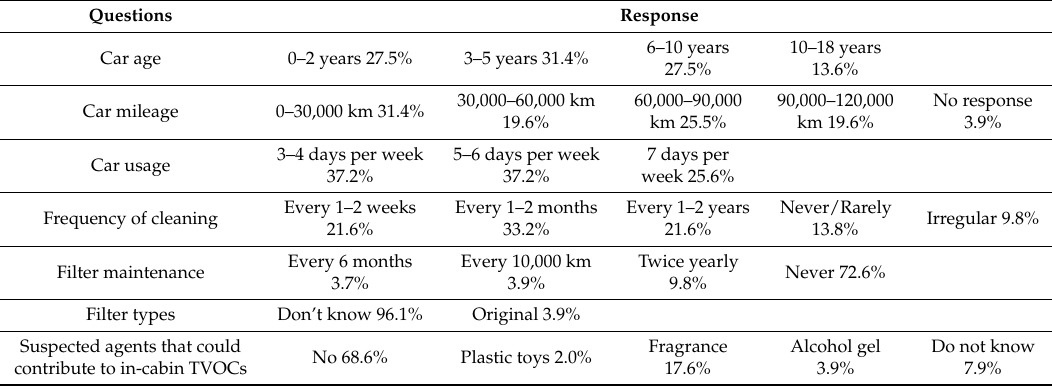
Table 2. Questionnaire results regarding the vehicles and the driver perception of the outdoor and in-cabin air